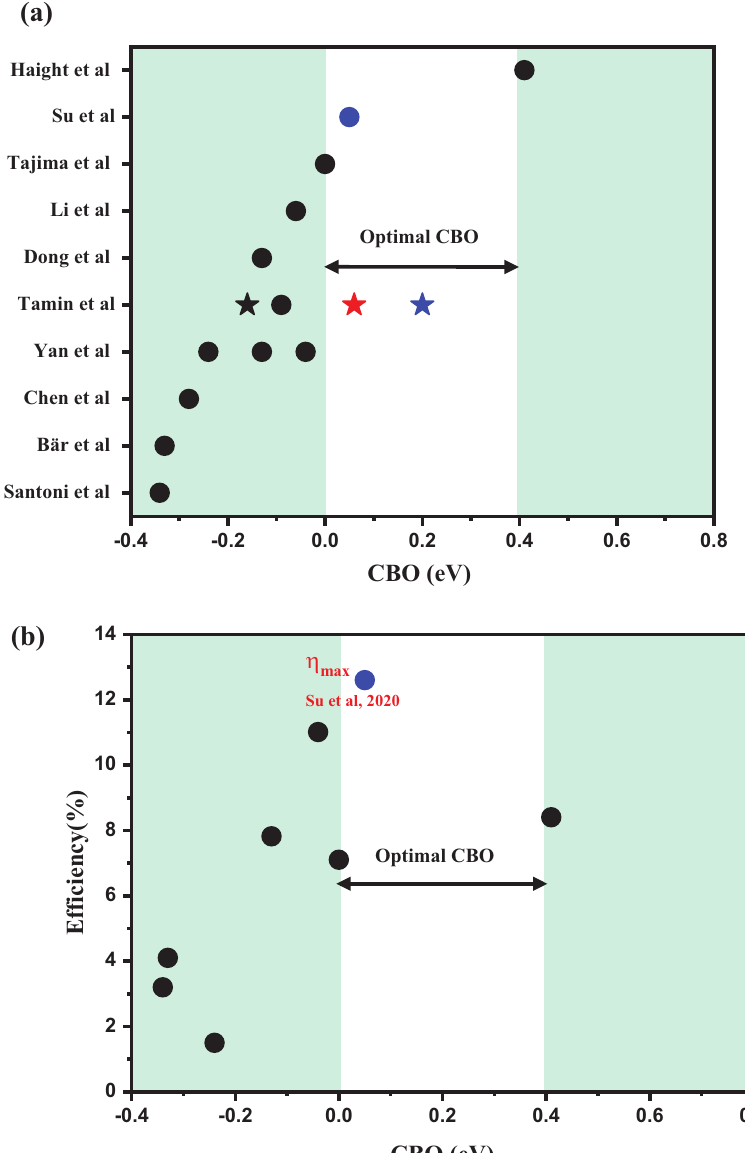
Fig. 7. (a) An overview of all the experimental work reported in the literature on the CBO value of pure sul fi de keserite. (b) An overview of the performance of solar cells based on pure sul fi de in the literature as a function of CBO